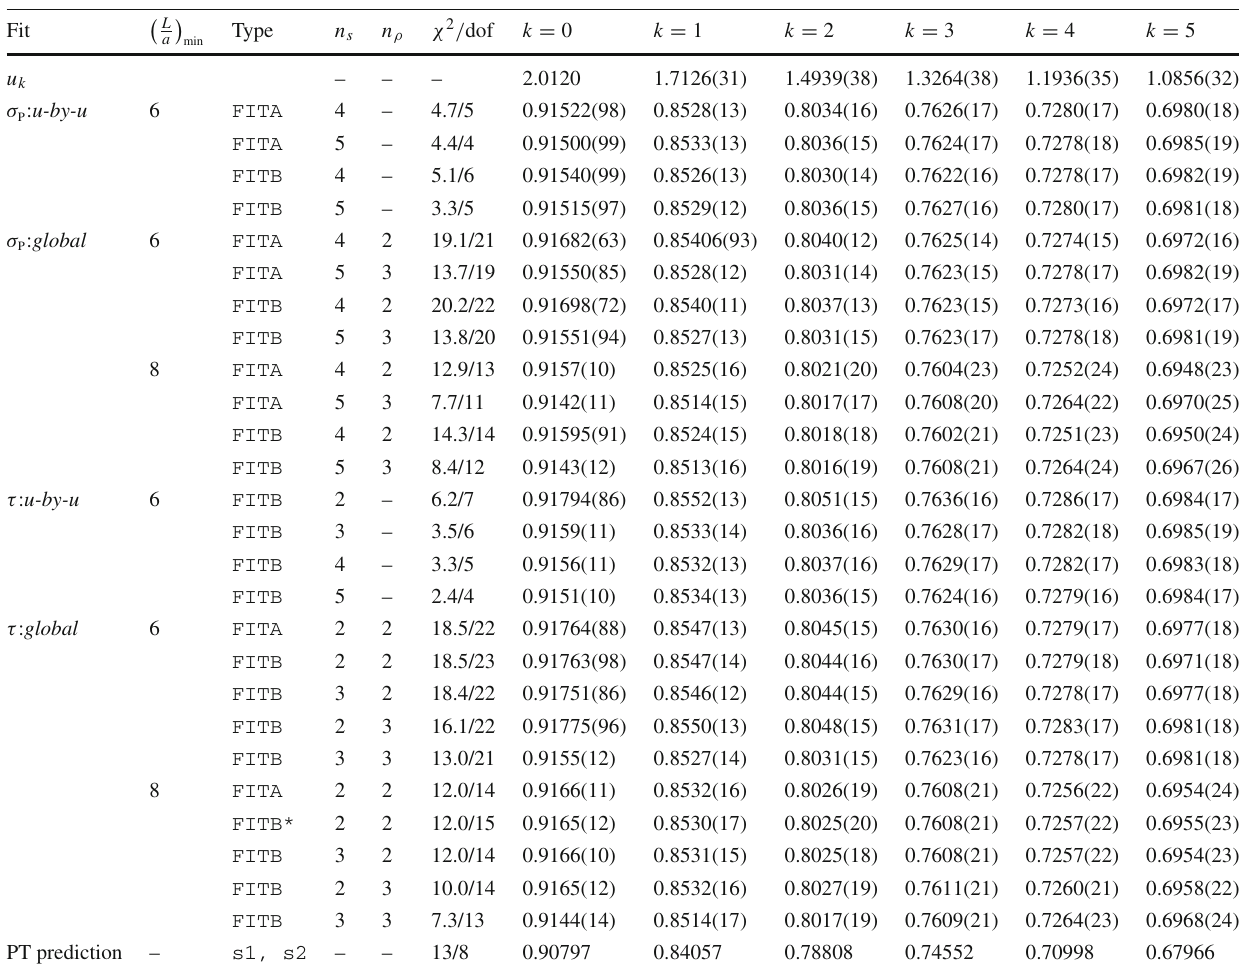
Table 7 Mass-ratios R ( k ) , cf. Eqs. (3.7) and (3.10), as obtained from different analysis procedures. The quoted values of u k have been obtained using Eq. (2.34) with b eff